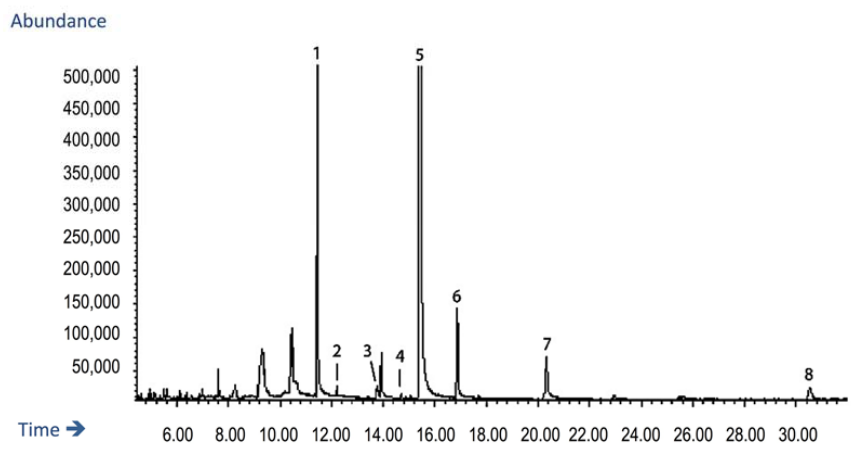
Figure 1. GC ‐ MS total ion current (TIC) chromatogram of the Lupinus mutabilis ( LM) extract. From the MS spectra, the fragmentation patterns of the eluting peaks were compared against the Wiley 275 mass spectral library, and the following compounds were tentatively assigned: Peak 1 Sparteine MW 234; peak 2 Palmitic acid MW 256; peak 3 Linoleic acid and Oleic acid MW 280 and 282 respectively; peak 4 and 5 Lupanine/ α‐ Lupanine MW 248; peak 6 Nuttalline MW 264; peak 7 Oxylupanine MW 264, and peak 8 11,12 ‐ Dehydrolupanine MW 246.